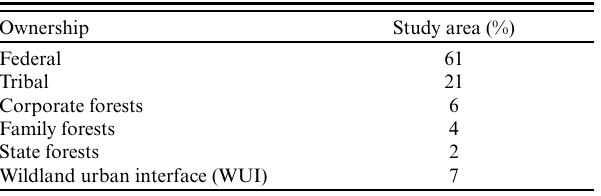
Table 1 . Ownership types and corresponding proportion of the study area used in the simulation experiment.